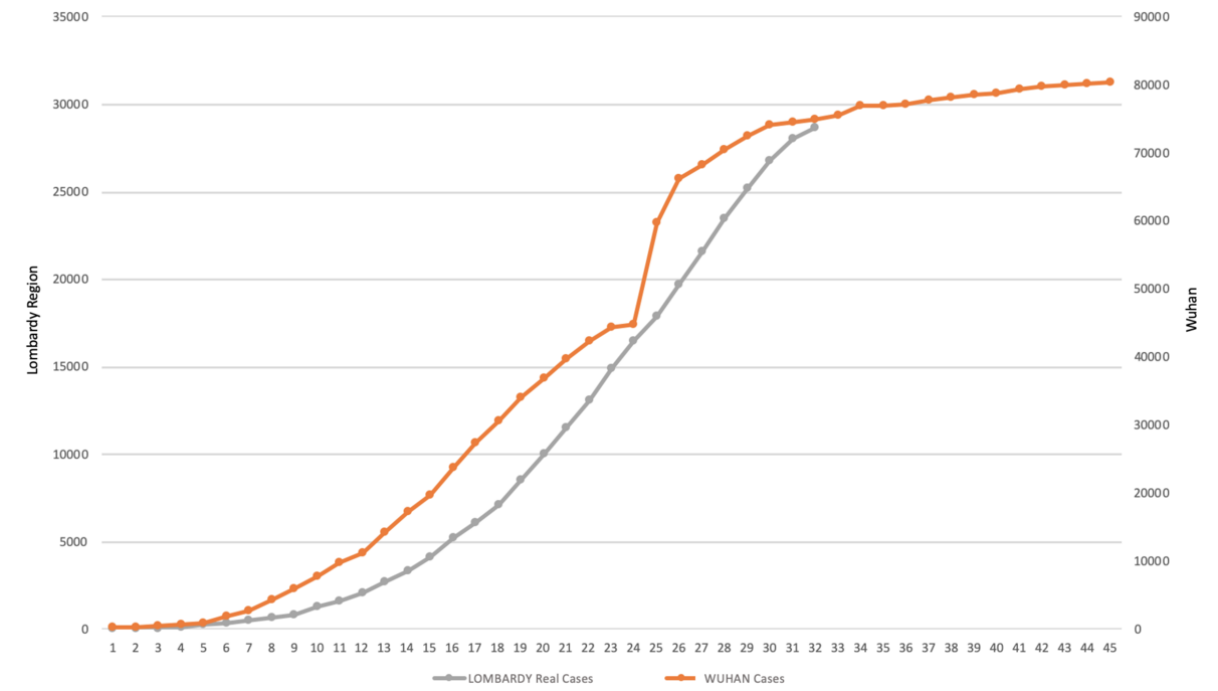
Figure 4. Graphical comparison between the Lombardy Region curve and the Wuhan curve (total cumulative positive